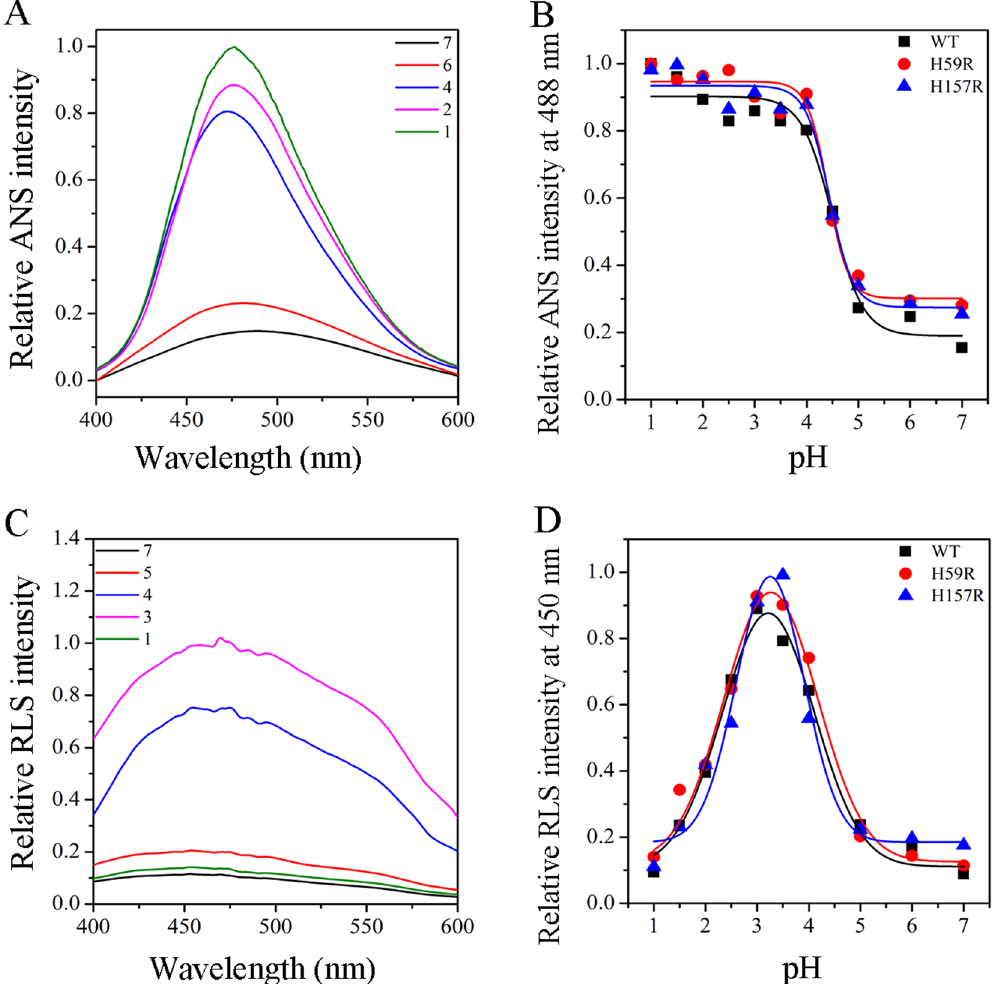
Figure 4. The ANS and RLS spectra of Pin1-WT, H59R and H157R by acidic pH treatments. ( A ) The representative ANS fluorescence spectra of Pin1-WT. ( B ) Relative ANS intensity at 488 nm of Pin1-WT, H59R and H157R. ( C ) The representative RLS fluorescence signal of Pin1-WT. ( D ) Relative RLS intensity at 440 nm of Pin1-WT, H59R and